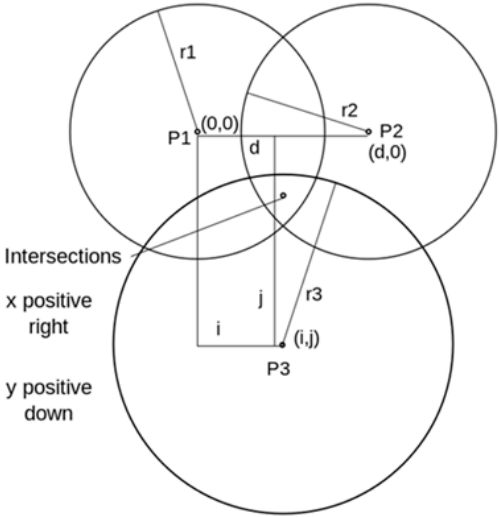
Figure 3. An Example of Trilateration. Figure 3. An example of